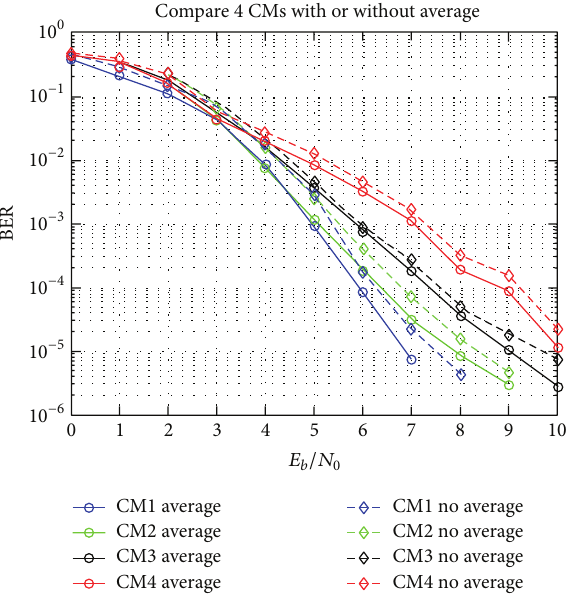
Figure 9: BER performance under FM band channel